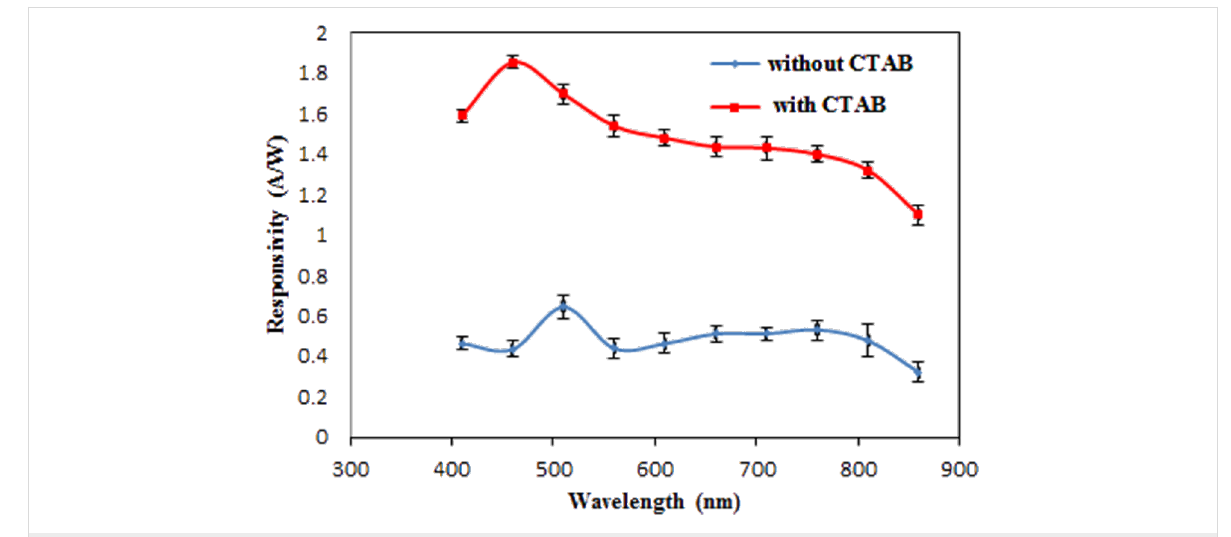
Figure 13: Spectral responsivity Ag 2 S/Si prepared with and without CTAB